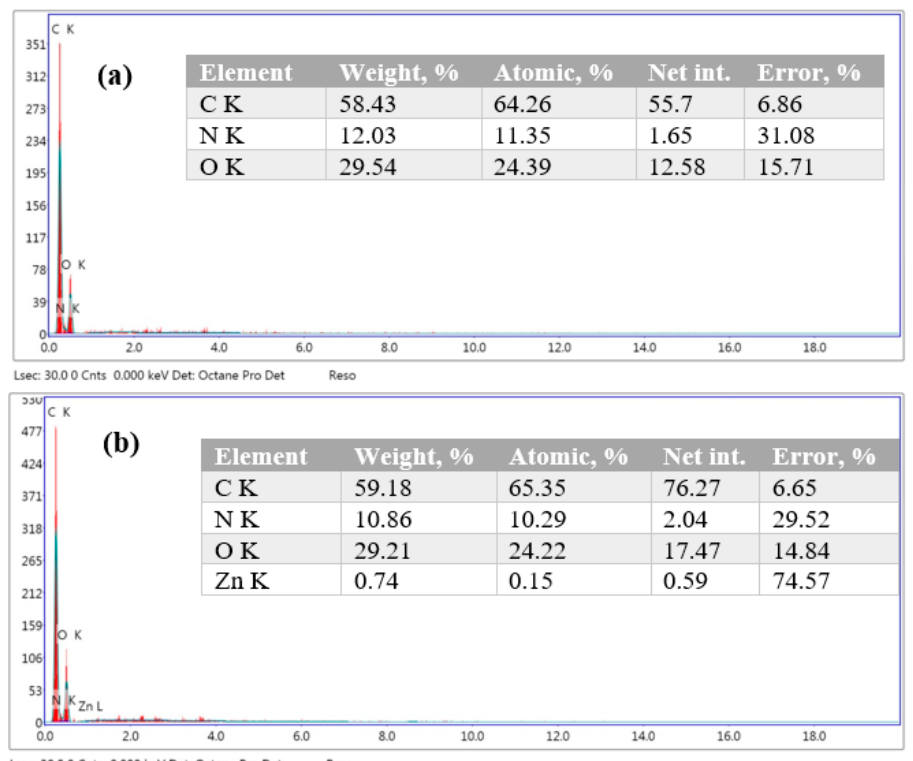
Figure 4. SEM micrographs of PUF/rGO/ZnO nanocomposite ( a ) at low magnification, ( b ) at mid magnification, and ( c ) at high magnification.